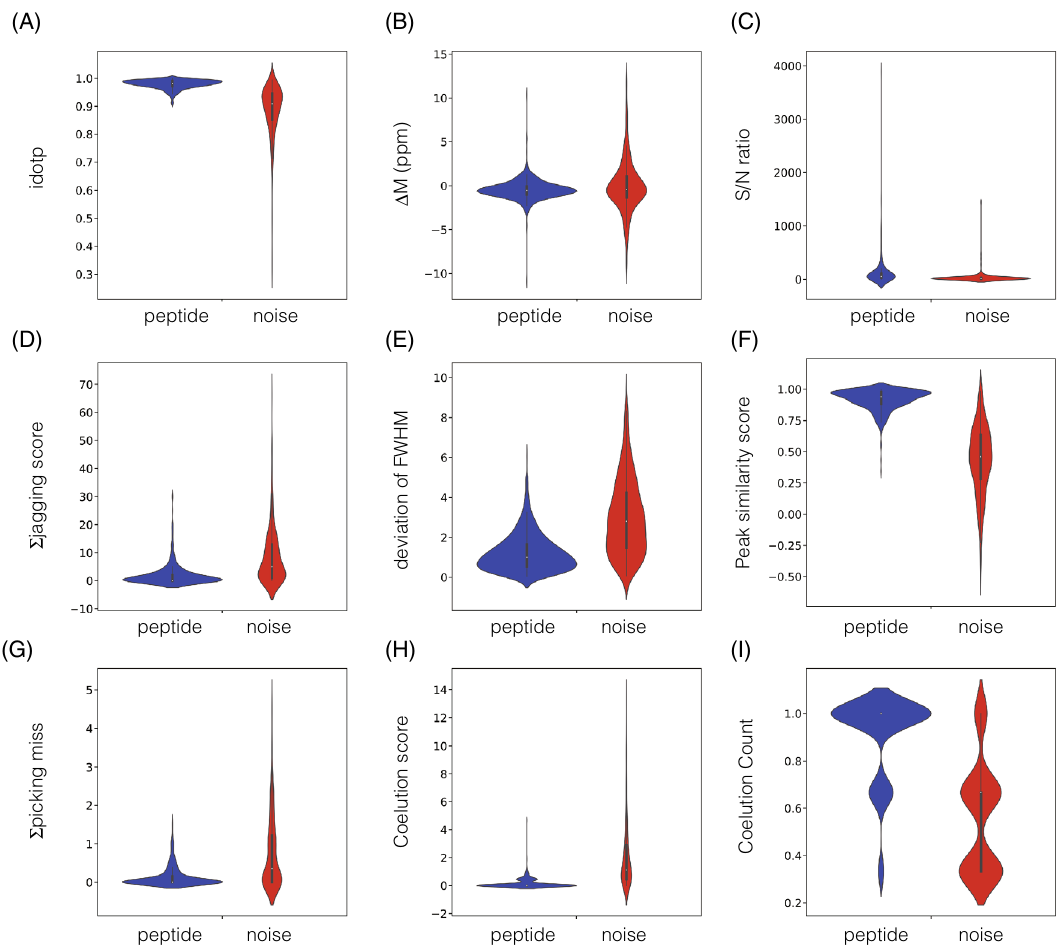
Figure 1. Violin plots of chromatographic features. ( A ) idotP, ( B ) average mass error among isotopes, ( C ) signal to noise ratio, ( D ) jagging score, ( E ) deviation of FWHM values among isotopes, ( F ) shape similarity score, ( G ) intensities at integral boundaries, ( H ) co-elution score, ( I ) co-elution count. Peptide and noise peaks are depicted in blue and red,